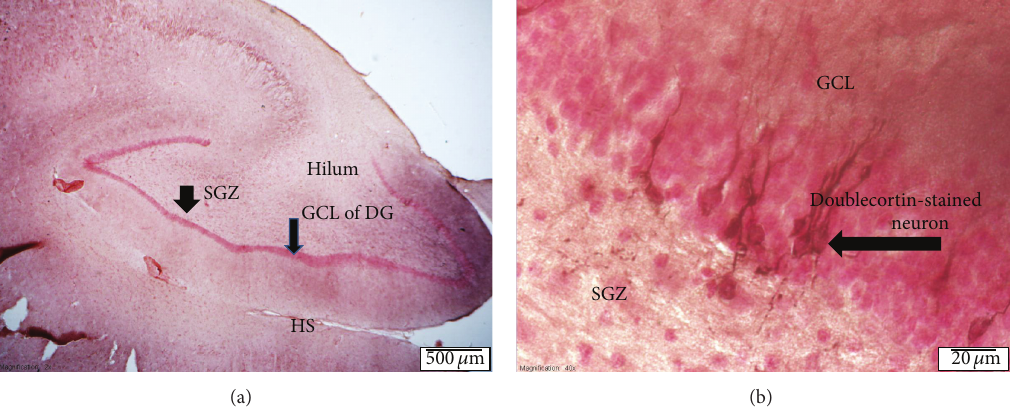
Figure 1: Doublecortin staining of neurogenesis in the dentate gyrus of the hippocampus. In (a), we present the dentate gyrus (DG) of the left hippocampus at 2x magnification (see scale) and (b) is at 40x magnification of the dentate gyrus (see scale). Doublecortin stained neurons can be seen in red extending from the subgranular zone (SGZ) into the granule cell layer (GCL) with staining of tertiary dendrites. DG is dentate gyrus. SGZ is subgranular zone. HS is hippocampal sulcus. All sections are taken from the anterior